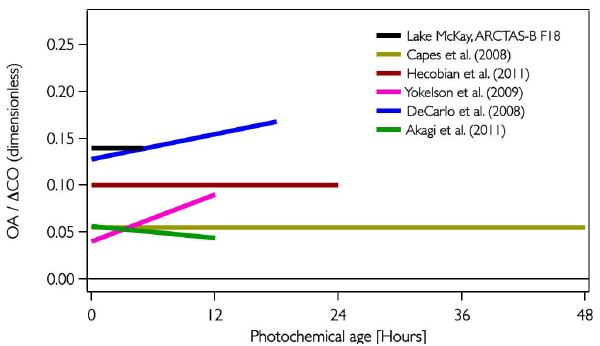
Fig. 7. Schematic summarising, for the available field BB datasets presented here and in the literature, the organic aerosol (OA) con- centration observed as a function of plume age, normalised to the enhancement in CO concentration above its background. Pho- tochemical age is the number of hours with an OH exposure of 1.5 × 10 6 that produce the same total estimated OH exposure of the field